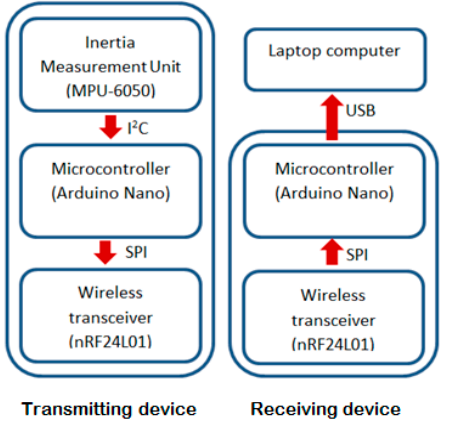
Figure 4. Accelerometry devices used for the tests.